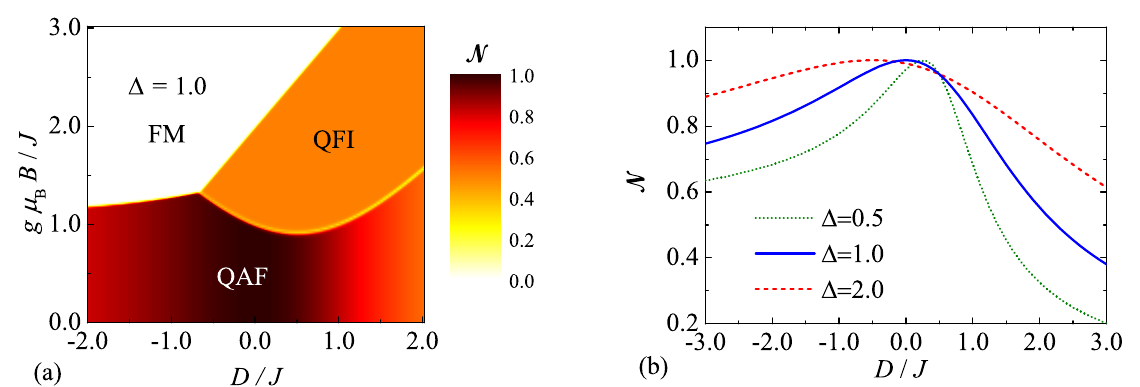
Figure 1. ( a ) Zero-temperature density plot of the negativity in D / J — g µ B B / J plane for the isotropic coupling constant with ∆ = 1; ( b ) The negativity as a function of the uniaxial single-ion anisotropy D / J for three different values of the exchange anisotropy ∆ = 0.5,1.0 and 2.0 at zero temperature and zero magnetic